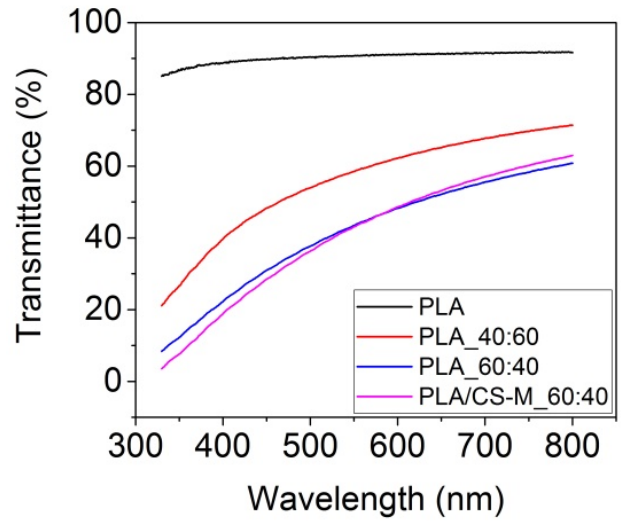
Figure 4. Transmittance by UV/VIS for some PLA-based materials films compared with neat PLA. Figure 4 revealed that the neat PLA film had a remarkable transmittance (~90%), while the PLA_40:60 film registered a transmittance of about 70% in visible, higher than the film containing PEG 8% (PLA_60:40). Further, the incorporation of 1 wt% CS-M into PLA matrix (PLA/CS-M_60:40) did not influence this optical characteristic. This